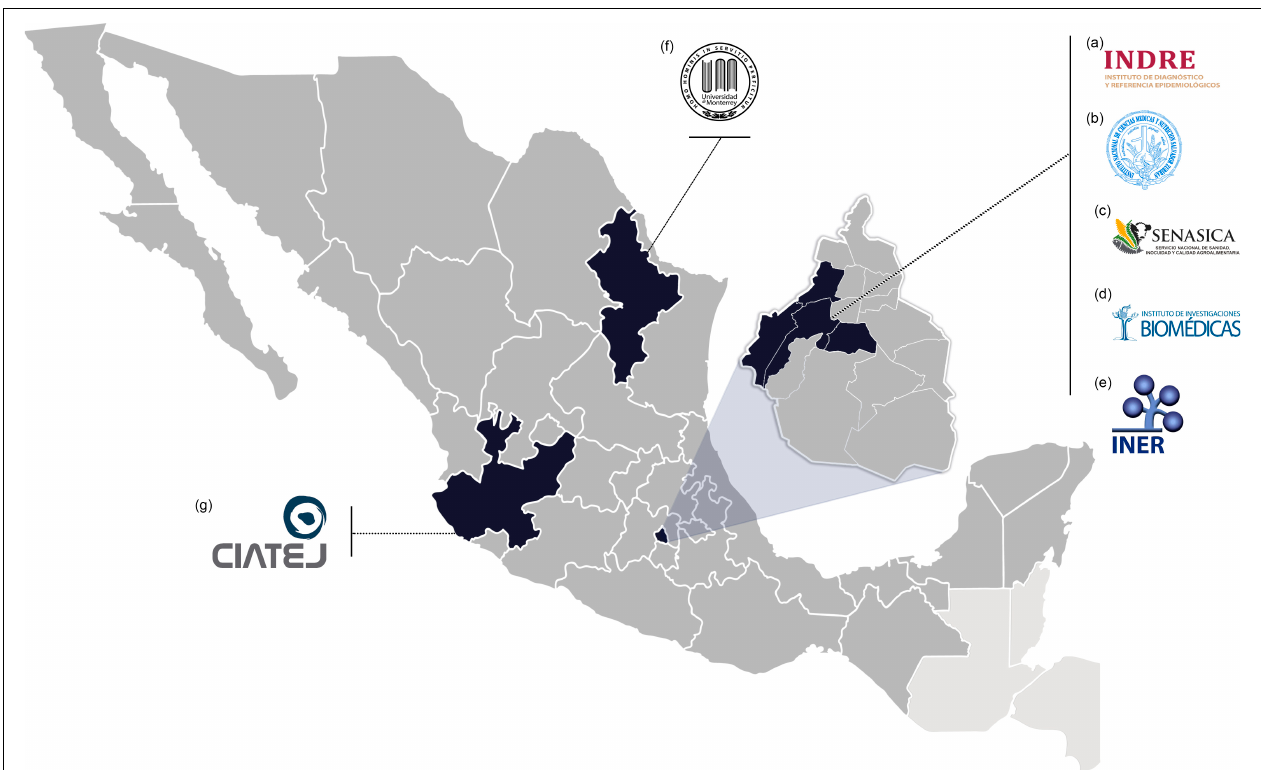
FIGURE 1 | Mexican BSL-3 laboratories. (a) BSL-3 Laboratory from the Institute for Epidemiological Diagnosis and Reference (Mexico City); (b) The Biosecurity Unit from Institute of Biomedical Research (UNAM, Mexico City); (c) Animal Health Laboratory from National Service of Agrifood Health, Safety, and Quality (Mexico City); (d) National Laboratory for Maximum Biological Safety from National Institute of Medical Sciences and Nutrition “Salvador Zubirán” (Mexico City); (e) Emerging and Non-Emerging Pathogens Research Tower from National Institute of Respiratory Diseases (Mexico City); (f) Center for Research and Assistance in Technology and Design of the State of Jalisco (Guadalajara City), and (g) University of Monterrey/Autonomous University of Nuevo León (Monterrey City).